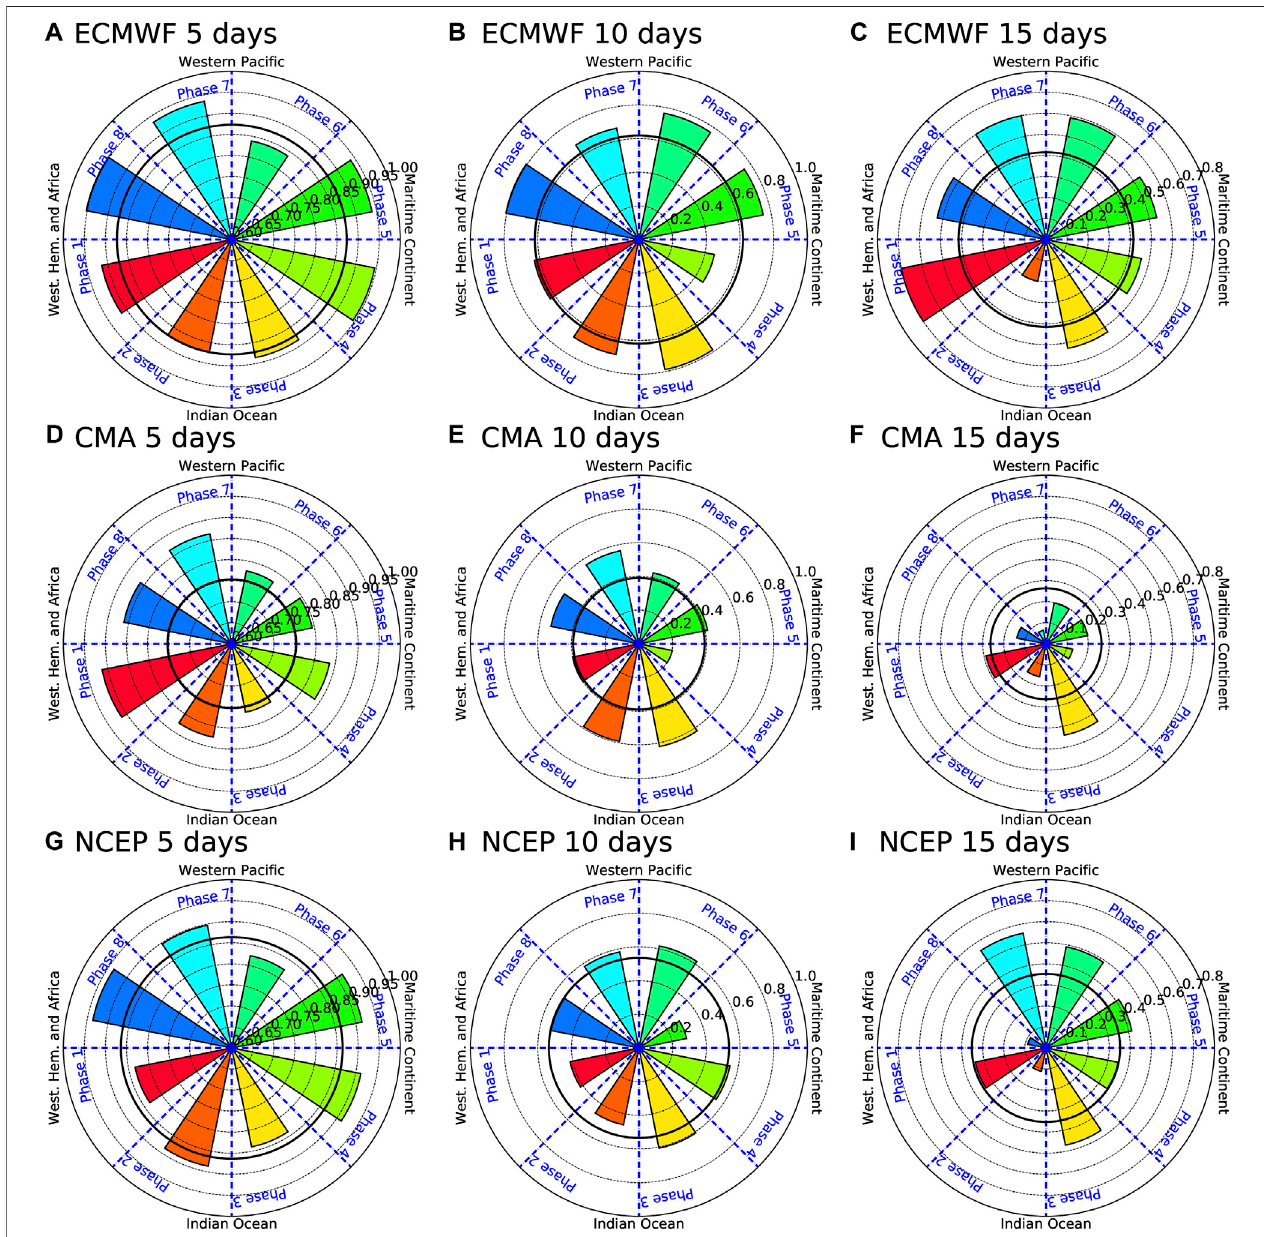
FIGURE7| Similarto Figure6 butforthepredictionskillwithMadden – JulianOscillation(MJO)indifferentphasesontheforecastdaysof5 (leftpanelsA,D, and G), 10 (middle panels B, E, and H) , and 15 (right panels C, F, and I) for European Centre for Medium-Range Weather Forecasts (ECMWF; top panels), China Meteorological Administration(CMA;middlepanels),andUnitedStatesNationalCentersforEnvironmentalPrediction(NCEP;bottompanels)modelsastheinitialdayisinthepositiveArctic Oscillation (AO) phase. The prediction skill in the eight MJO phases (phase 0) is present by bars with different colors (the circle with black solid line).